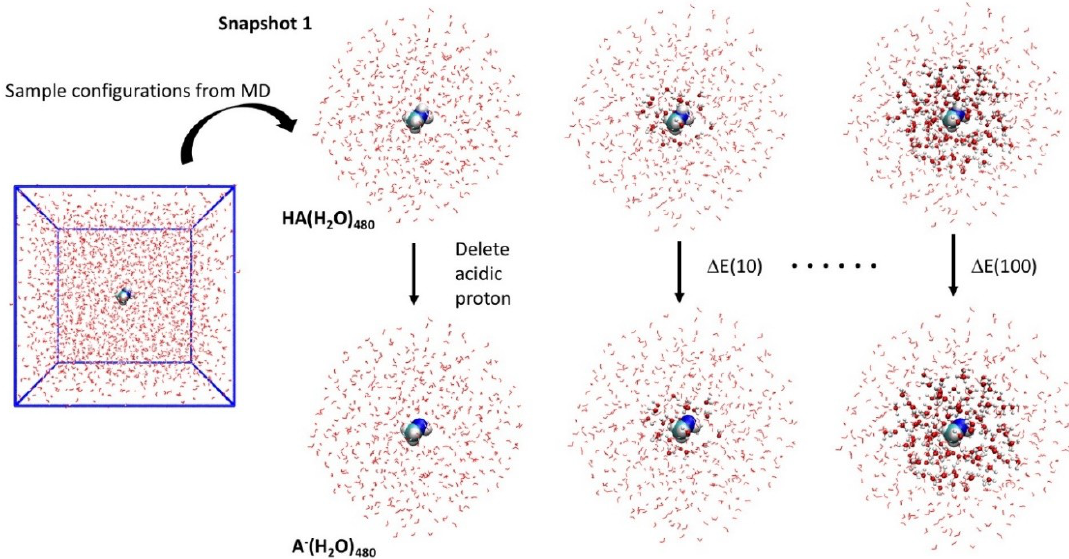
Figure 2. Snapshots of the solvated clusters ( m = 480) are collected from a molecular dynamics simulation of the solute in a periodic box of water. For a chosen snapshot, a series of quantum mechanics/molecular mechanics (QM/MM) models are set up by radially increasing the size of the QM region (balls and sticks) from the reaction centre. ΔE( m ) refer to the QM/MM simulation with m water molecules in the QM region. Errors in QM/MM models are measured from absolute deviations from the pure QM calculation of the full system, ΔE = ΔE (480).